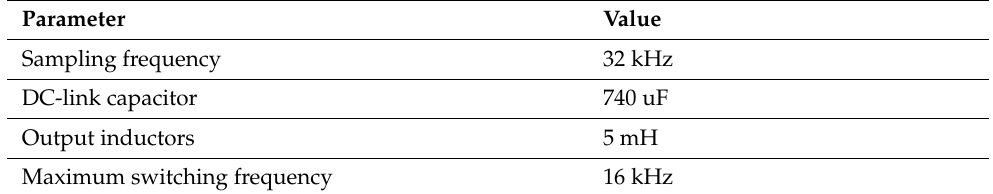
Table 4. ShAPF parameters